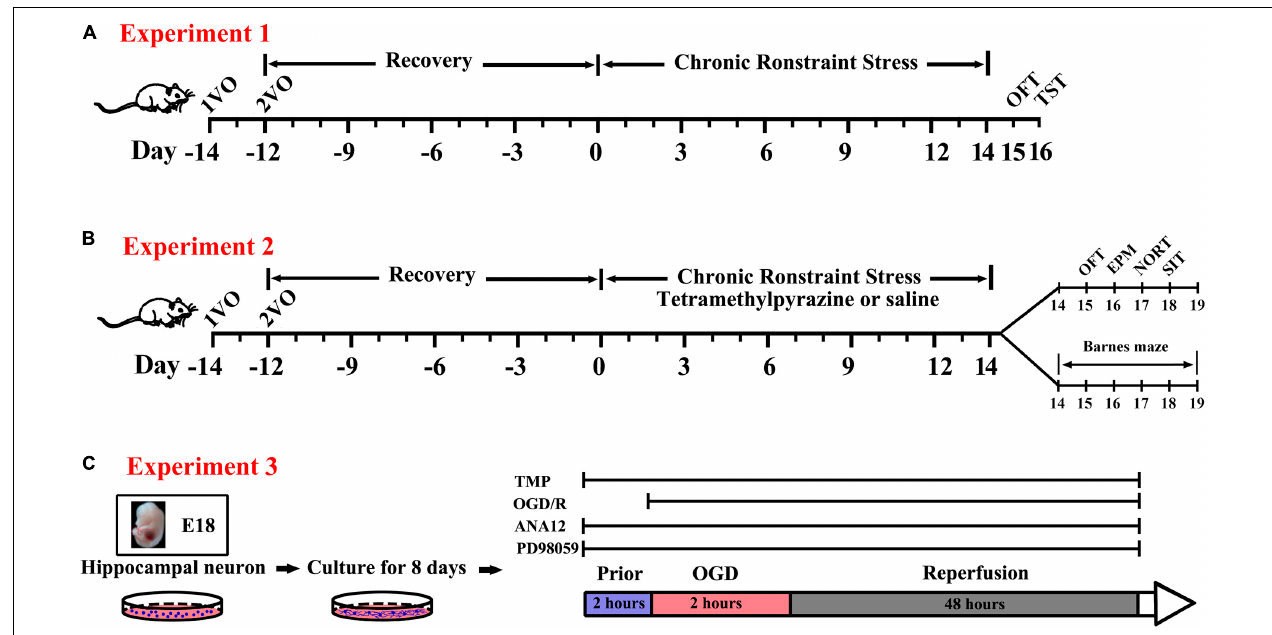
FIGURE 1 | Experimental protocol for in vivo and in vitro experiments in the present study. (A) Open field test (OFT) and tail suspension test (TST) were used to test the efficiency of the establishment of the rat BPSD model using a bilateral internal carotid artery occlusion (BCCAO) method combined with chronic restraint stress (CRS) in vivo (Experiment 1). (B) Exploring the effect of Tetramethylpyrazine (TMP) on behavioral recovery using a battery of behavioral assays following BCCAO/CRS in the rat BPSD model in vivo (Experiment 2). (C) Uncovering the role of TrkB/ERK/CREB signaling pathway in TMP exerting neuroprotective effect through fortifying synaptic remolding in vitro experiments (Experiment